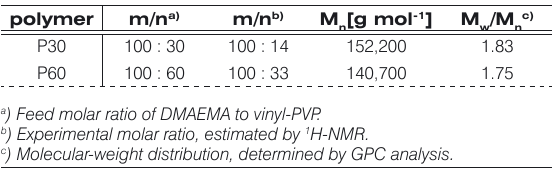
Table 1. Characterization and Polymerization Details for Copolymers.